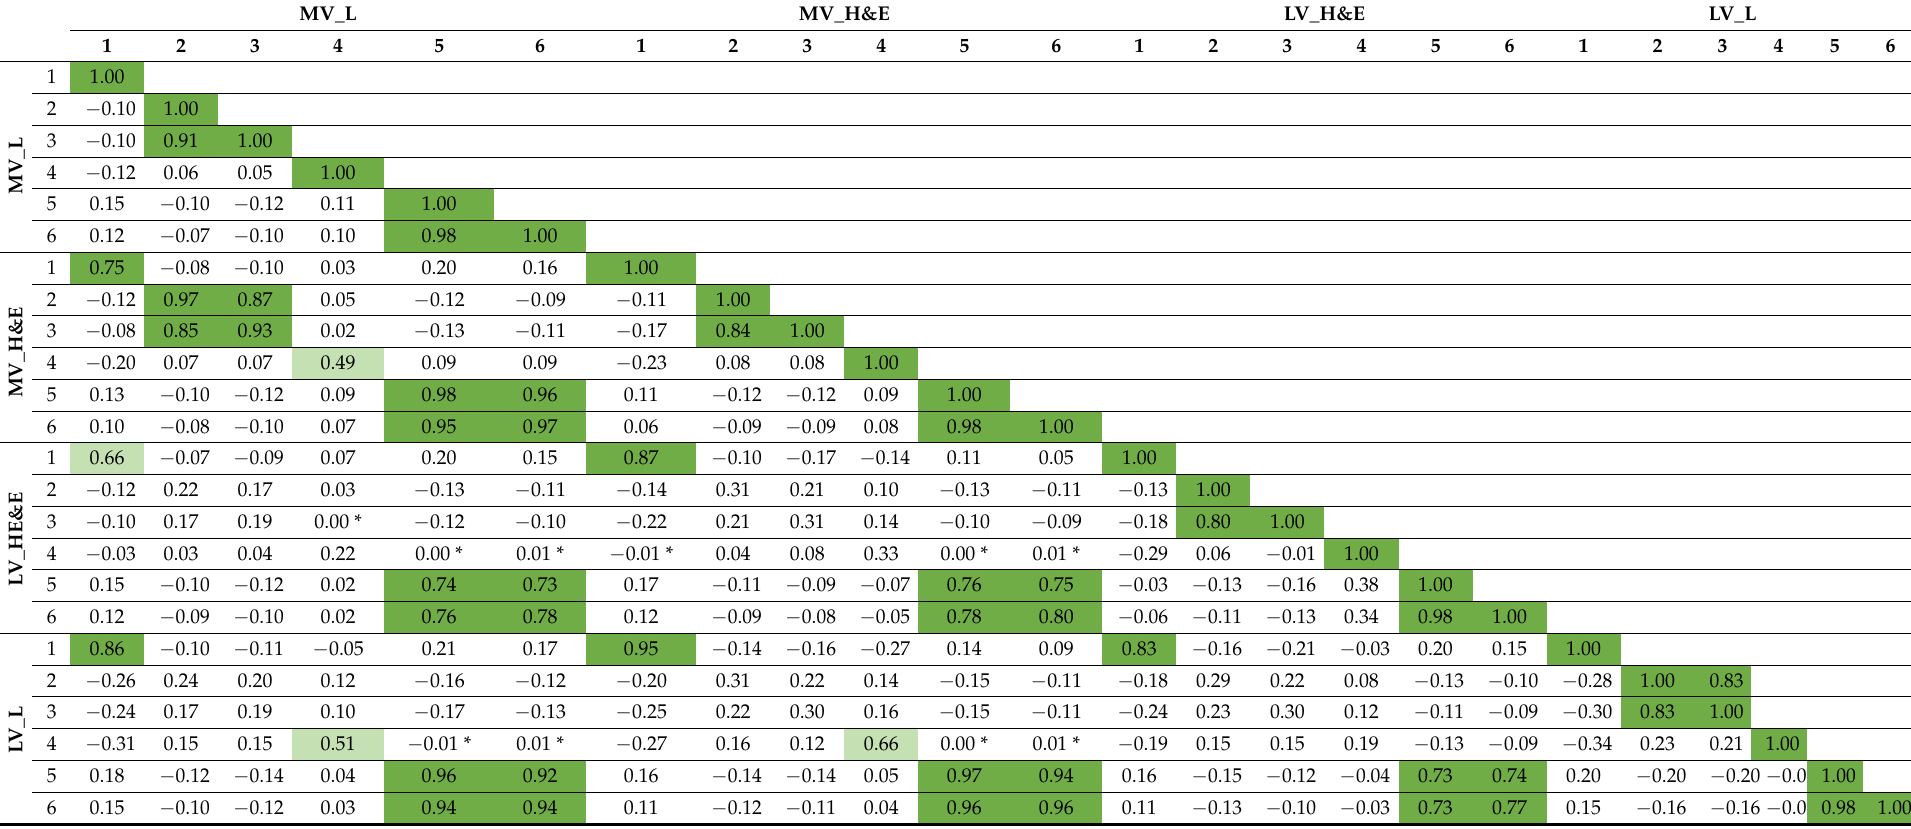
Table 4. Correlation using Pearson’s coefficient between global indicators for the investigated measurement points in the